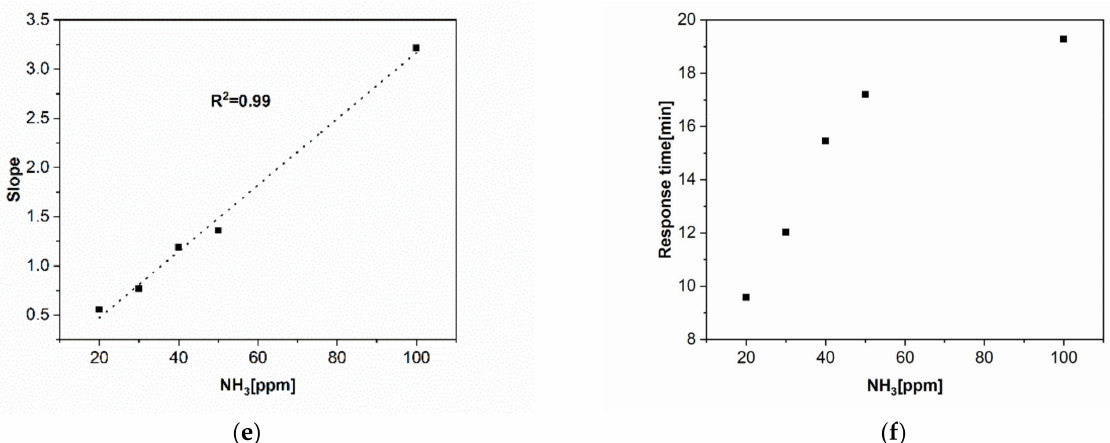
Figure 6. ( a ) Real-time measurements of a CNW sensor printed by LIFT collected for different concentrations, i.e., 20–100 ppm of NH 3 . ( b ) CNW sensor response as a function of NH 3 concentration at room temperature in N 2 depicting a good linear relation. ( c ) Response values of a laser-printed CNW-based sensor after 1.5, 5, 10, 20, and 30 min of exposure to NH 3 . ( d ) Responses after 1 min of exposure of the laser-printed CNW-based sensor to different concentrations of NH 3 , i.e., the 20–100 ppm range, and the linear fit of the response. ( e ) The slope of the fit as a function of NH 3 concentration. ( f ) Response times for the laser-printed CNW-based sensor exposed to different concentrations of NH 3 (20–100